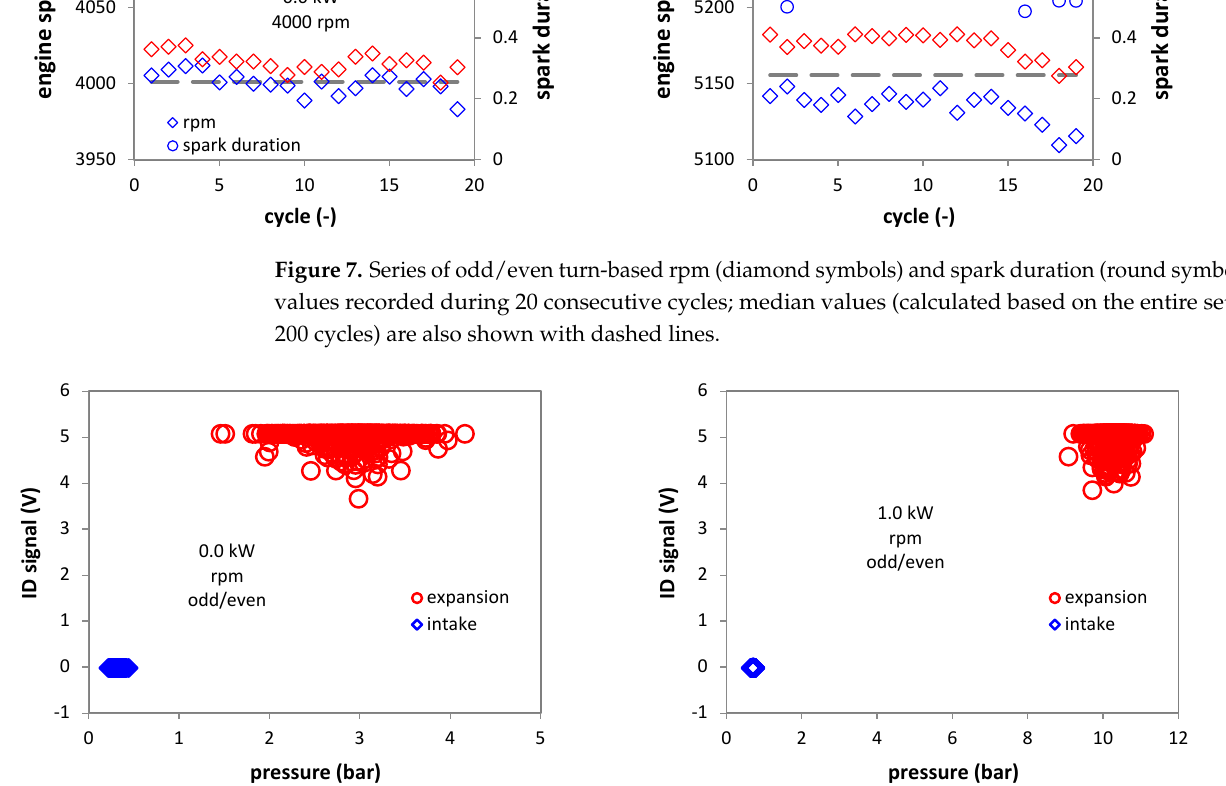
Figure 7. Series of odd/even turn-based rpm (diamond symbols) and spark duration (round sym- bols) values recorded during 20 consecutive cycles; median values (calculated based on the entire set of 200 cycles) are also shown with dashed lines.